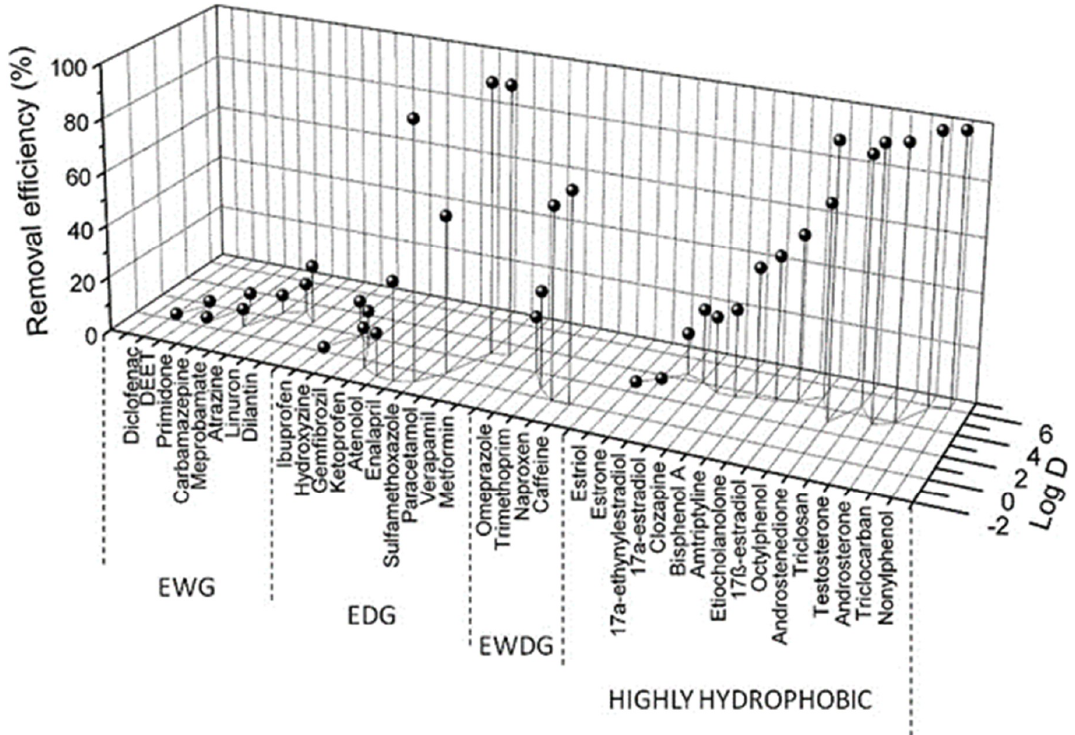
Figure 3. Effect of functional groups and hydrophobicity on the removal of OMPs in the AnMBR [89]. Reproduced with permission from [89], Copyright Water Research, 2014.